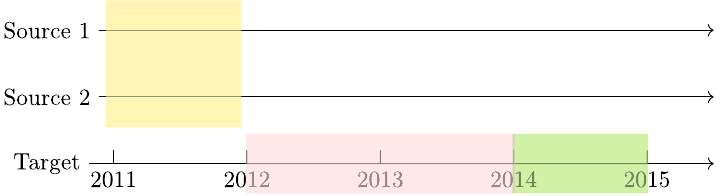
Fig. 3 As training data for the generative method, we choose the first year of source data (yellow). As test data for the forecasting method, we use the last year of the target data (green). As available real target data, we consider up to two years in 2012 and 2013 (red)